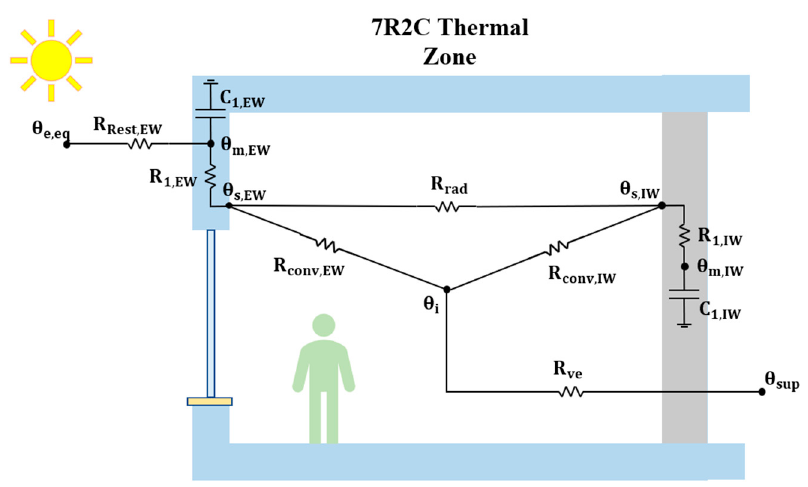
Figure 1. 7R2C thermal network simplified representation.